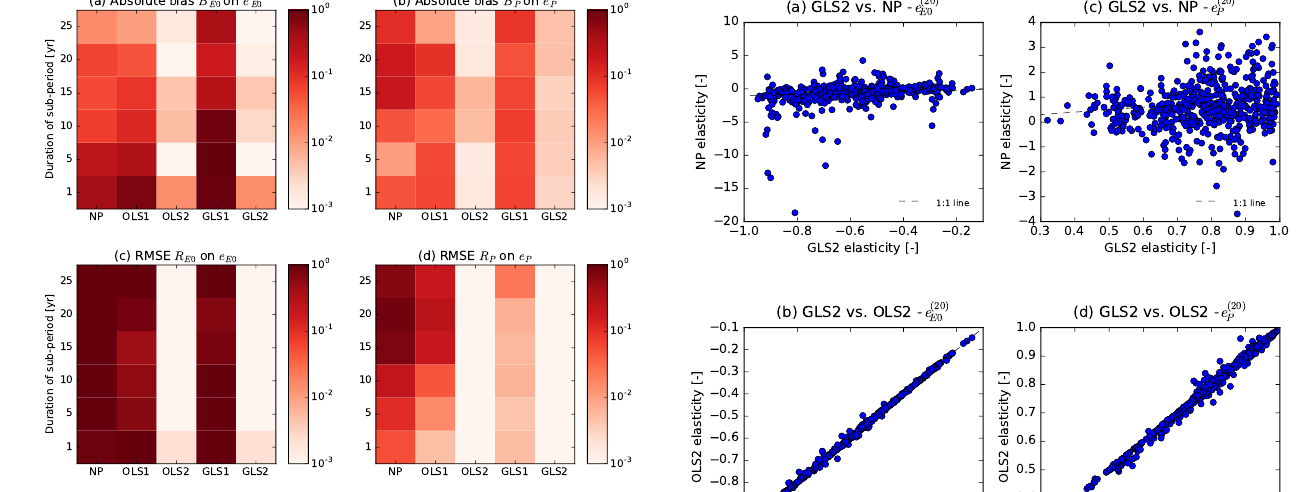
Figure 6. Performances of the five models proposed to compute em- pirical elasticity, tested on synthetic data generated with the Turc– Mezentsev model.